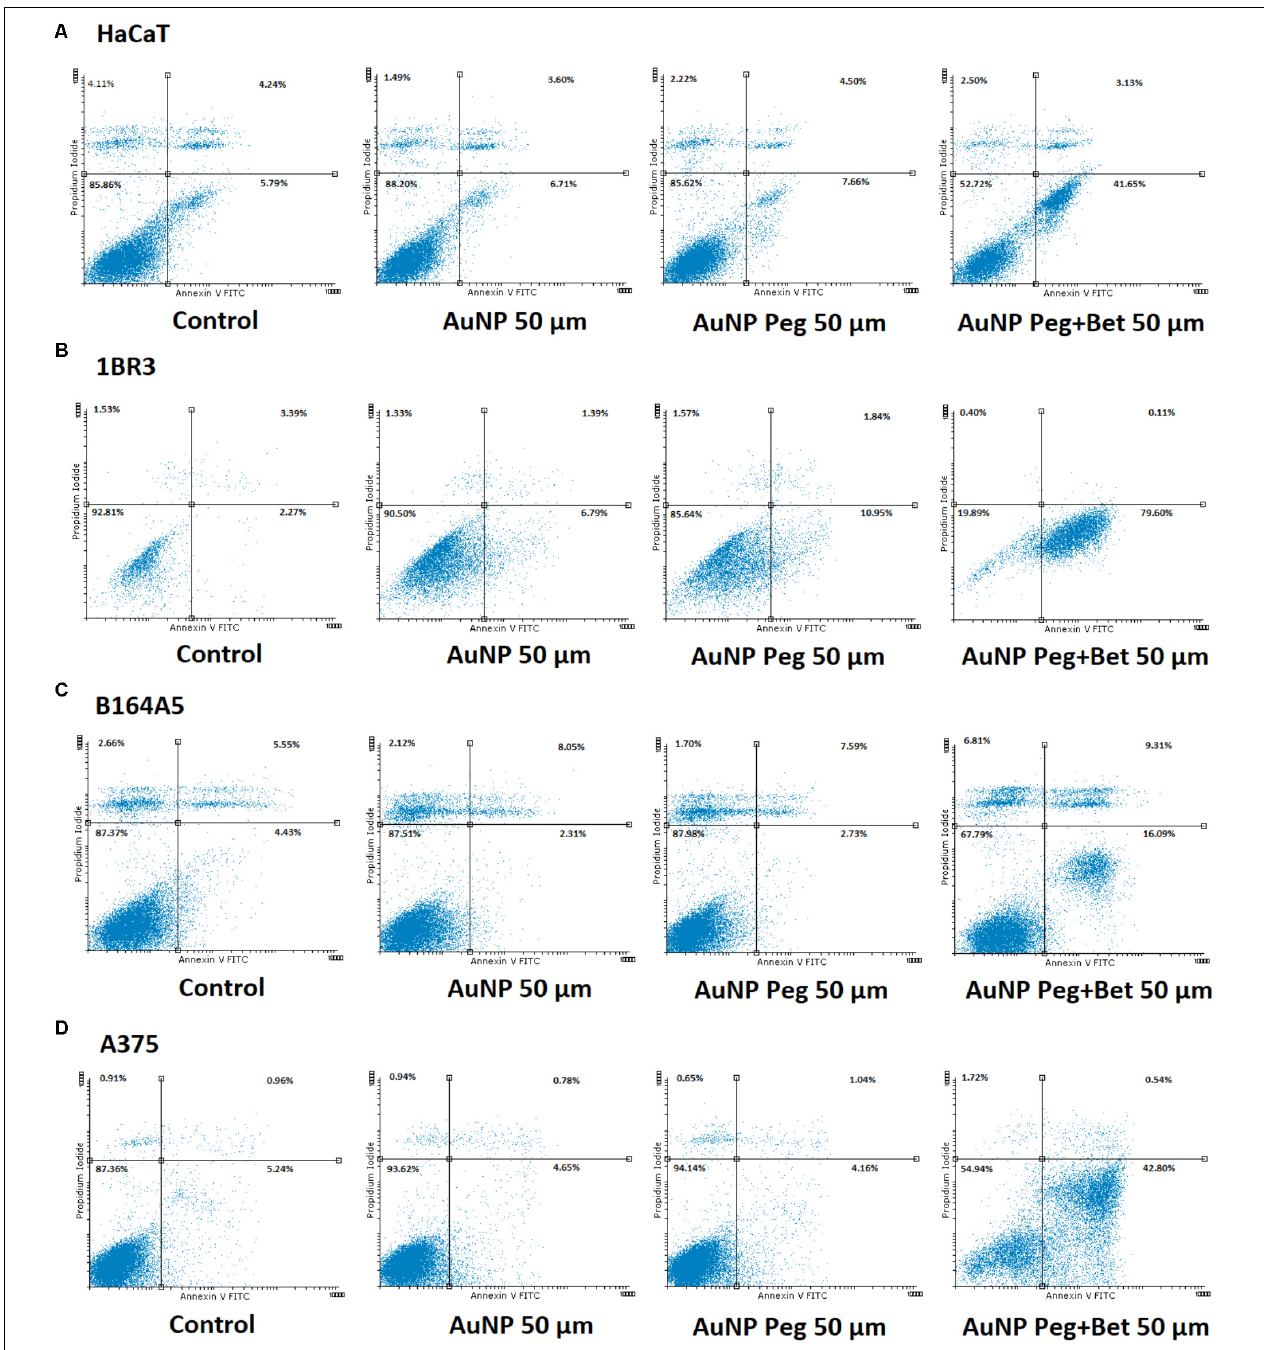
FIGURE 8 | Representative dotplots of apoptotic cells stained with Annexin V-FITC/PI and analyzed by flow cytometry after 72 h treatment, grouped as follows: (A) HaCat: Control, AuNP 50 µ M, AuNP Peg 50 µ M, AuNP Peg + Bet 50 µ M; (B) 1BR3: Control, AuNP 50 µ M, AuNP Peg 50 µ M, AuNP Peg + Bet 50 µ M; (C) B164A5: Control, AuNP 50 µ M, AuNP Peg 50 µ M, AuNP Peg + Bet 50 µ M; and (D) A375: Control, AuNP 50 µ M, AuNP Peg 50 µ M, AuNP Peg + Bet 50 µ M. Selection of the dotplots was based on the significant pro-apoptotic effects induced by test compounds at 50 µ